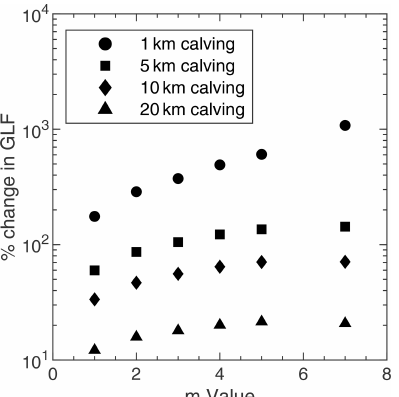
Figure E1. The instantaneous increase in grounding line flux for four of the idealised calving experiments, plotted as a function of the different stress exponents ( m values) tested in the Weertman sliding law (Eq. 5). The four calving experiments are those in which the calving front was moved to 1, 5, 10 and 20km downstream of the main grounding line, as described in Sect.